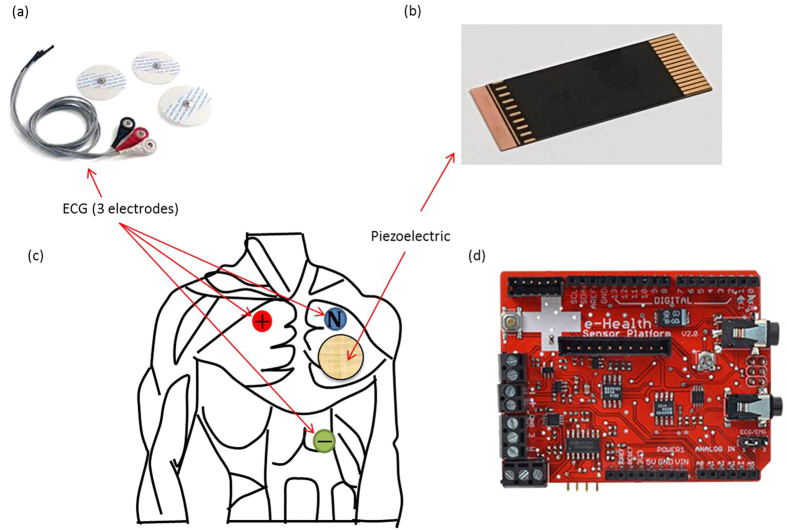
Devices and experimental setup: (a) three electrode ECG system13, (b) a piezoelectric sensor12, (c) measurements setup illustration and (d) eHealth platform shield13.